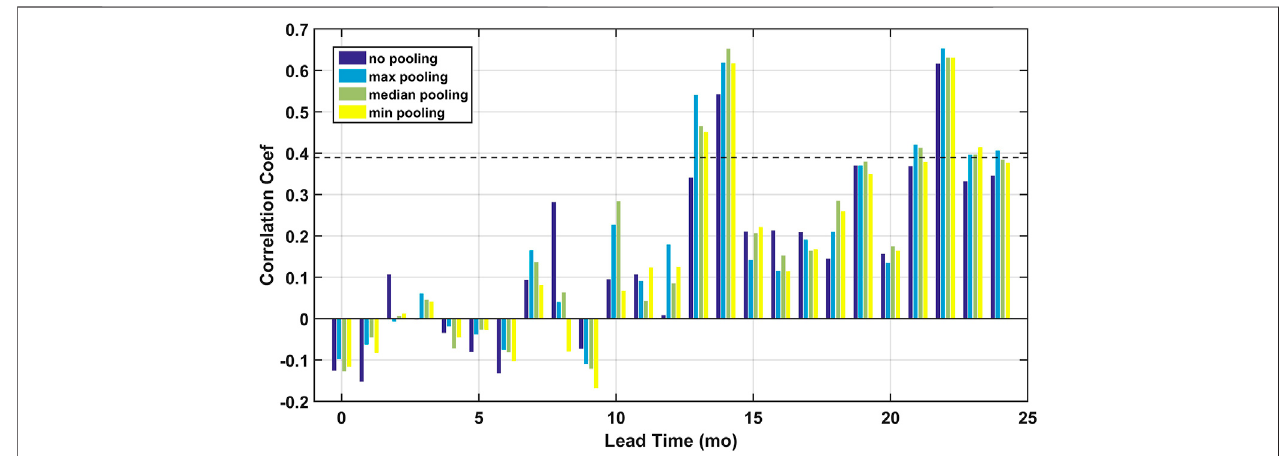
FIGURE 3| Comparison ofthe predictive skill in the testing period from the elastic net regression models with no pooling (dark blue), maximum pooling (light blue), median pooling (green) and minimum pooling (yellow). The p -value (cid:1) 0.1 signi fi cance level is plotted in the black dashed line.